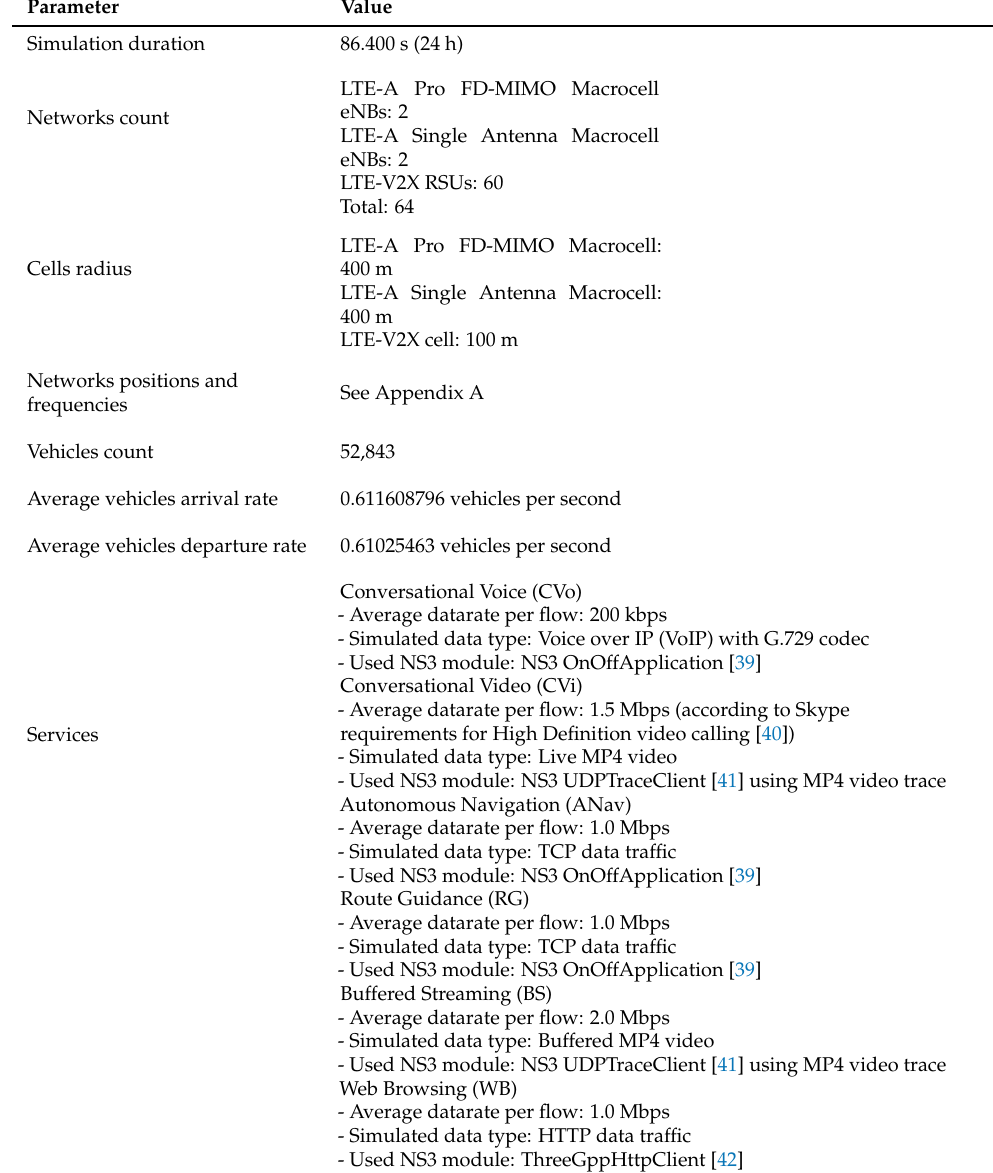
Table 4. The simulation